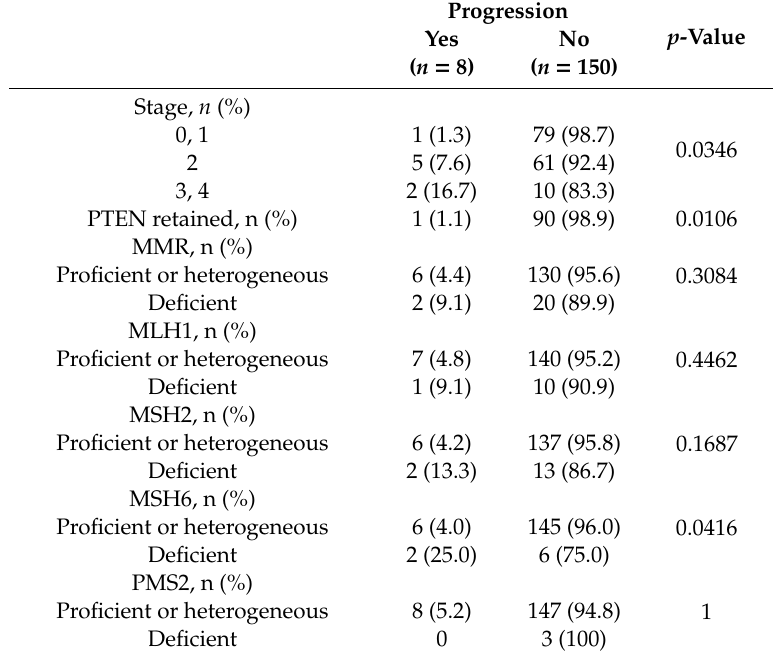
Table 3. Bivariate analysis showing the association of selected clinicopathologic characteristics with tumor progression in Luminal A breast cancers. MLH1, mutL homologue 1; MSH2, mutS homologue 2;